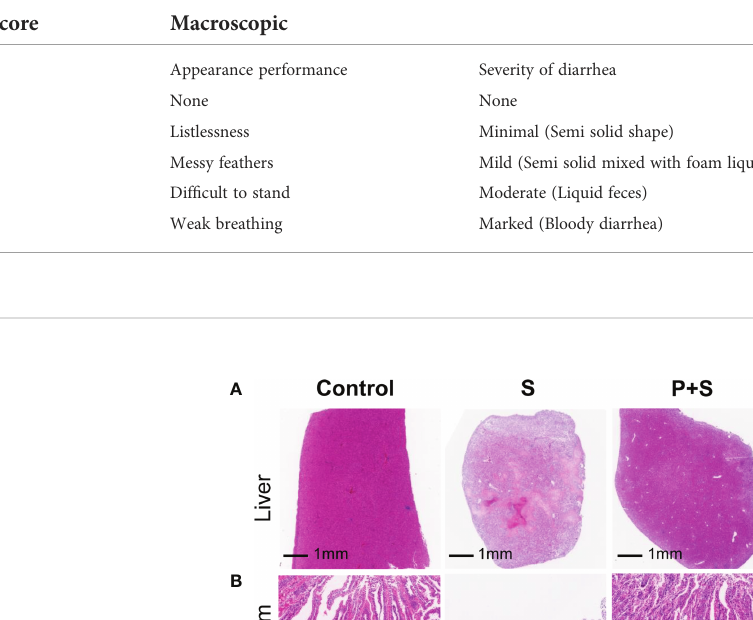
TABLE 1 Gross and microscopic pathology scoring criteria.